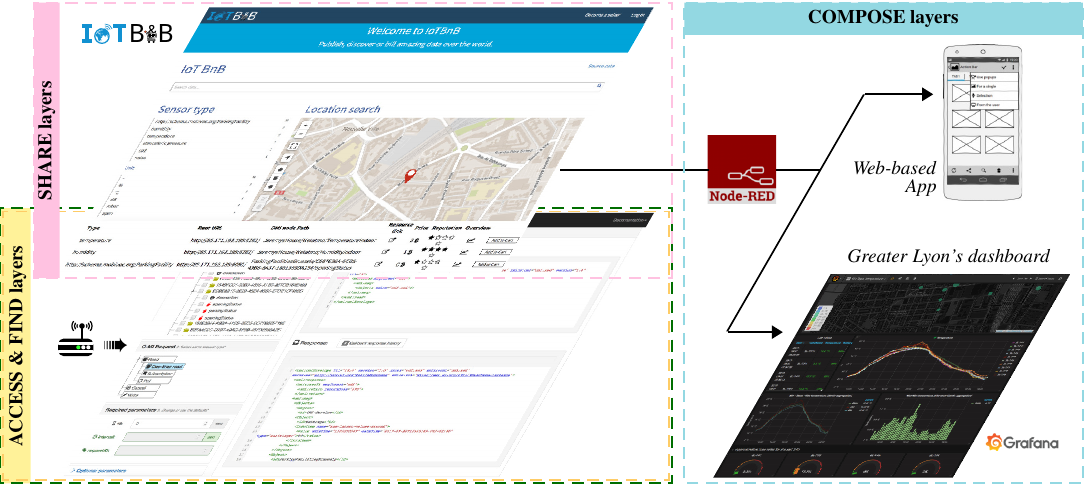
Figure 12. Screenshot overview of tools related to the ACCESS, FIND, SHARE & COMPOSE